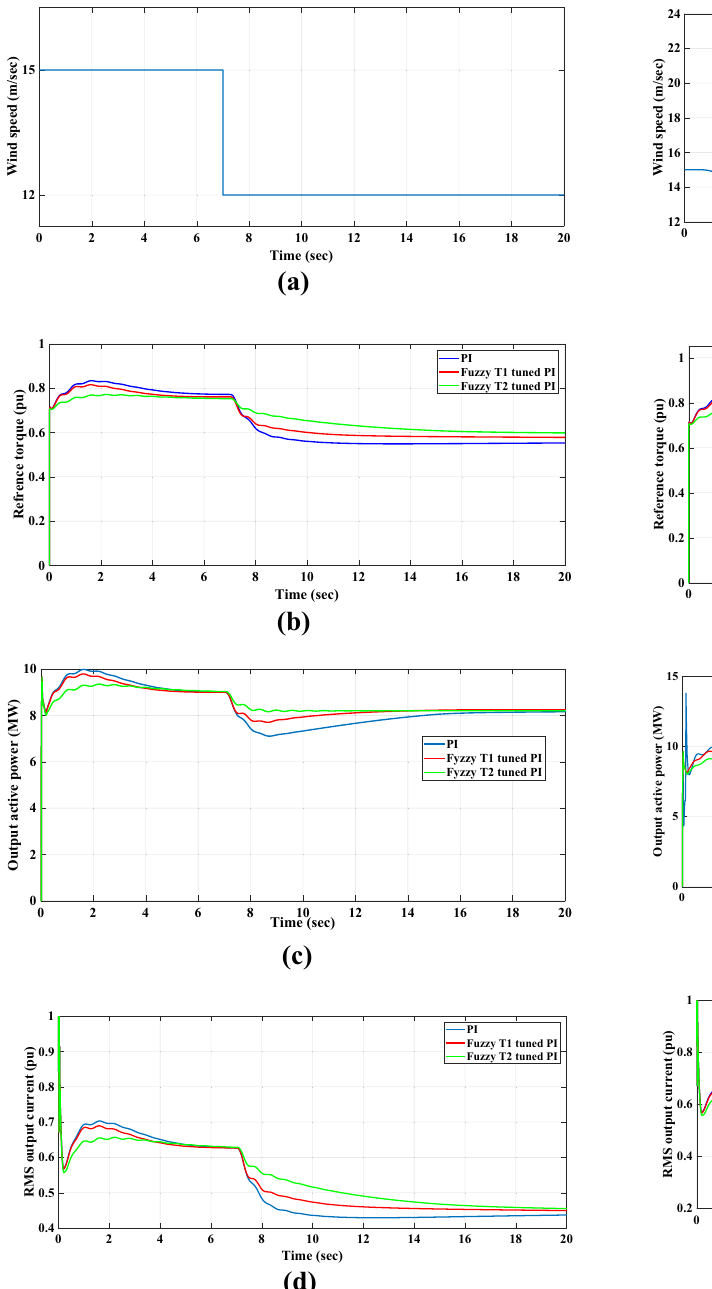
Fig. 10 Step change a wind speed, b reference torque, c output active power, d output current